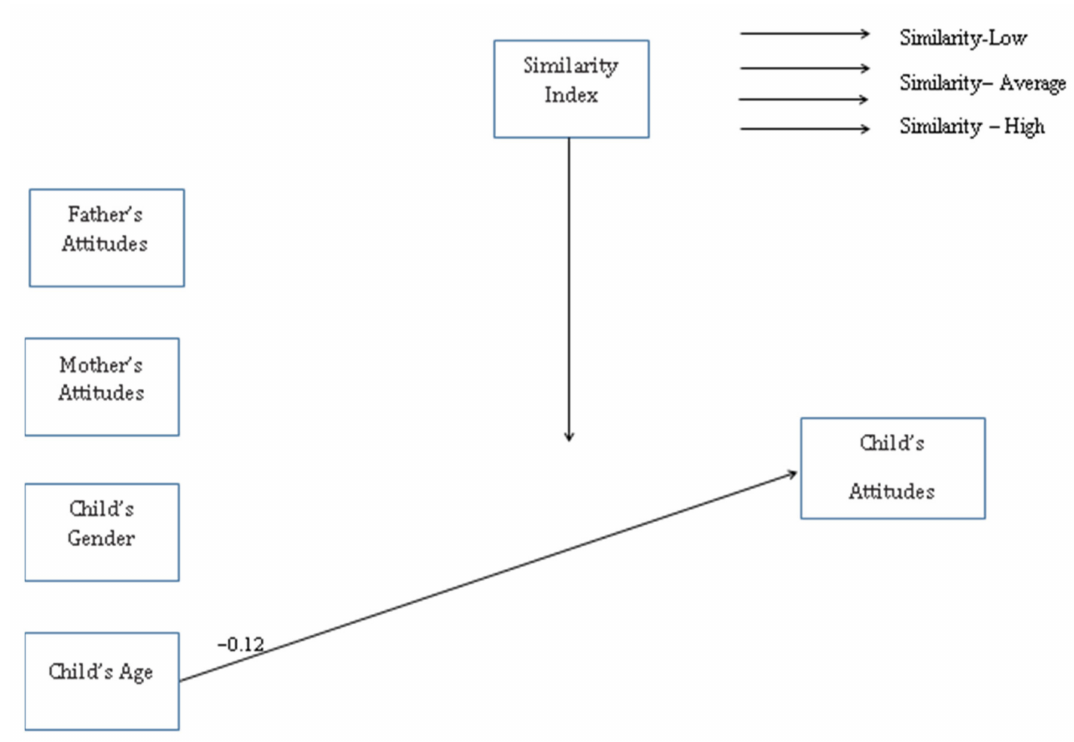
Figure 3. Attitudes toward children with